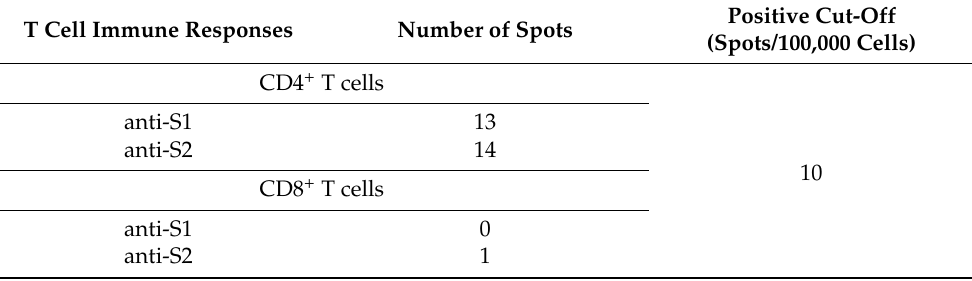
Table 1. T cell immune responses explored after both booster vaccine dose and COVID-19 infection in Patient